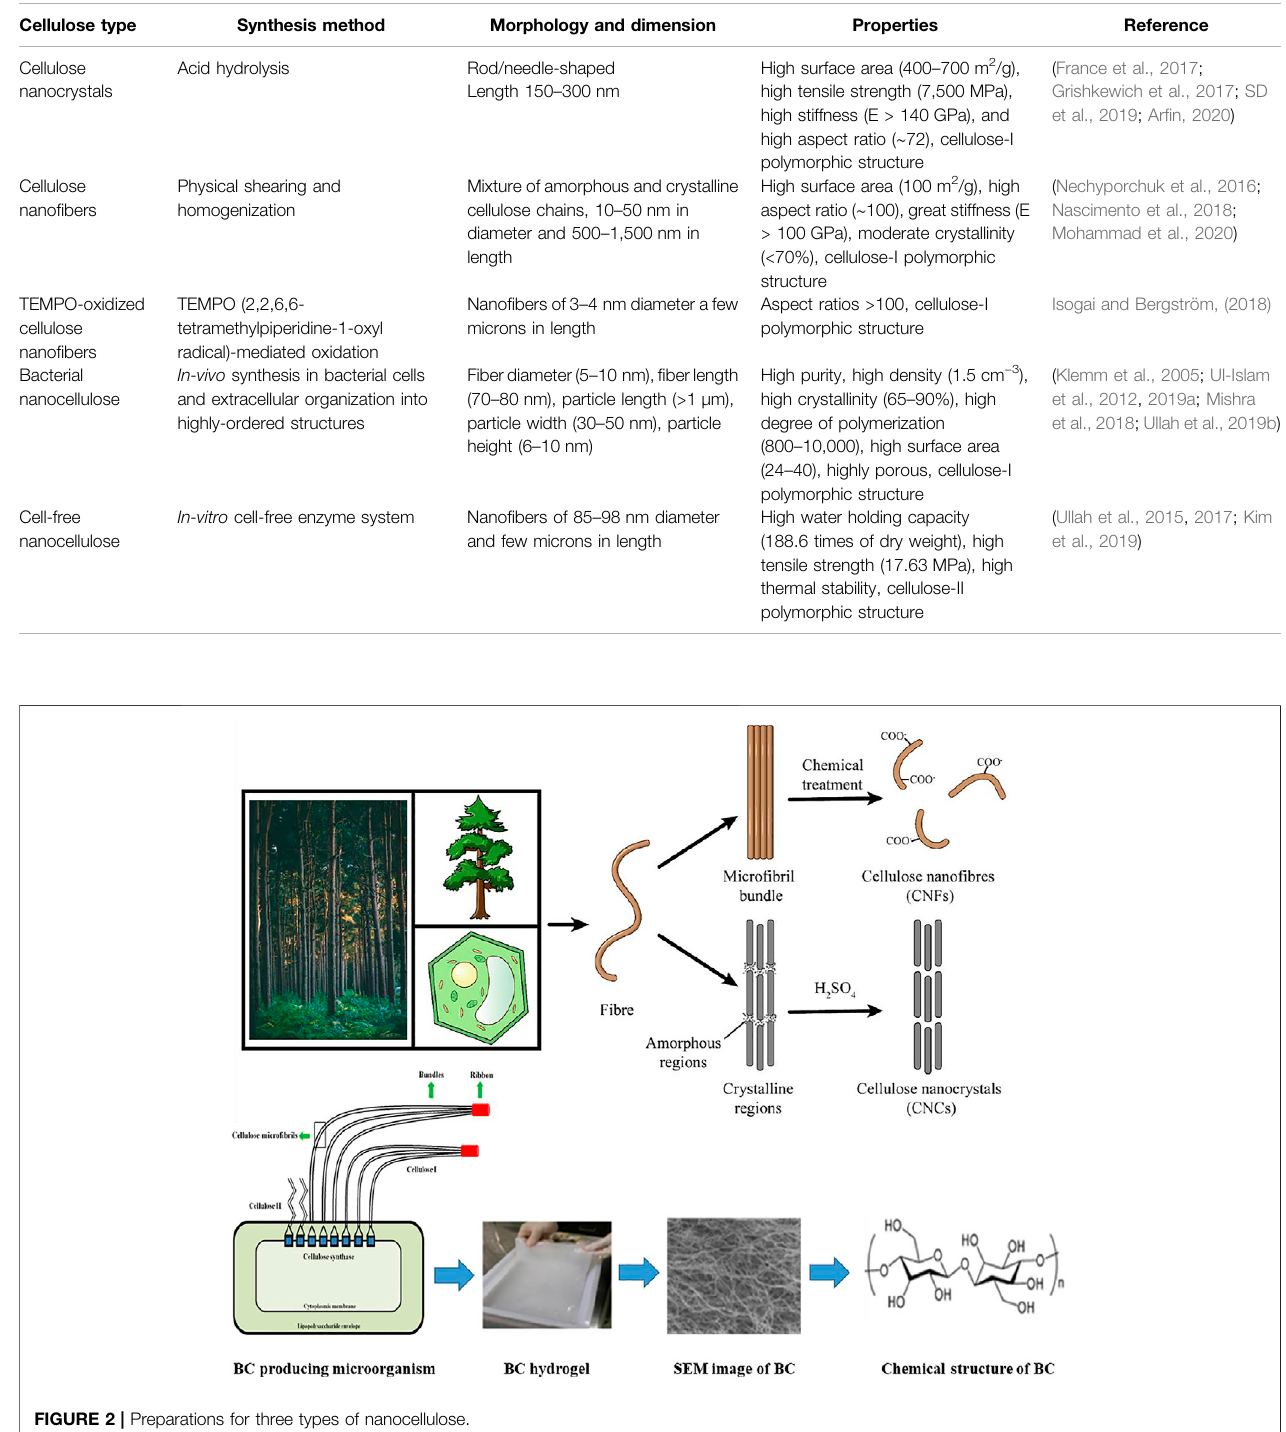
TABLE 1 | A comparative analysis of synthesis, morphology, dimension, and properties of different types of nanocellulose.